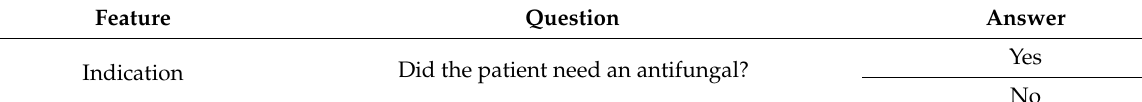
Table 1. Score for evaluating appropriateness of antifungal (AF)